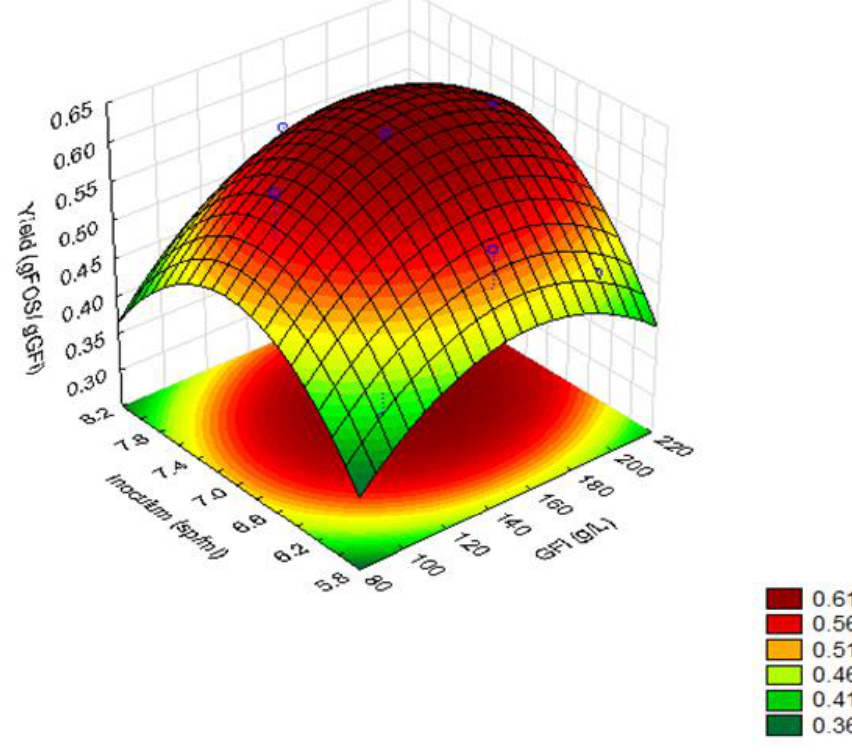
Figure 2. Response Surface plot of the effect of initial sucrose (GFi) concentration and inoculum concentration on fructooligosaccharides production yield (g FOS /g GFi ).